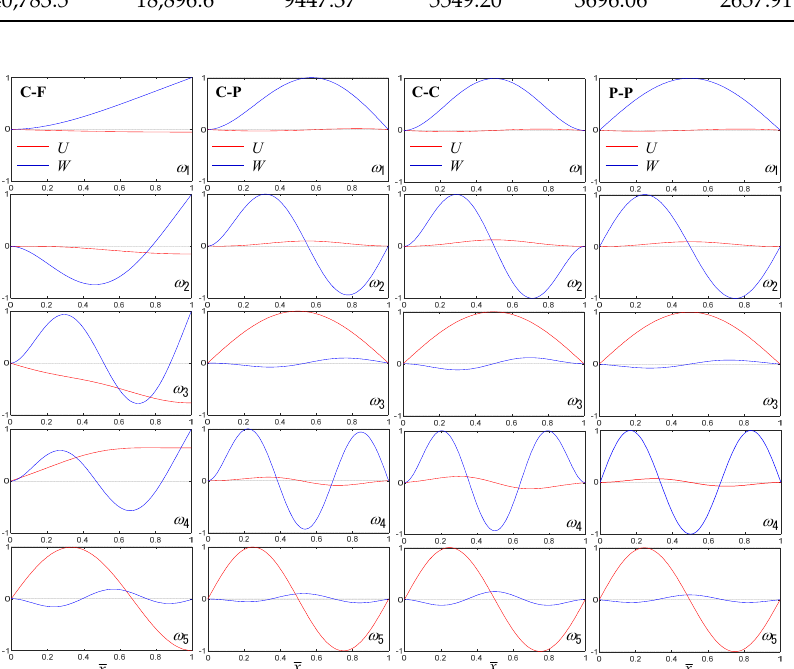
Figure 3. First five mode shapes of the symmetric three ‐ layered beam with four end conditions when L/h = 10. Table 3. Effects of the variation of L/h on the first five natural frequencies of the symmetric three ‐ layered beam with the classical boundary conditions.